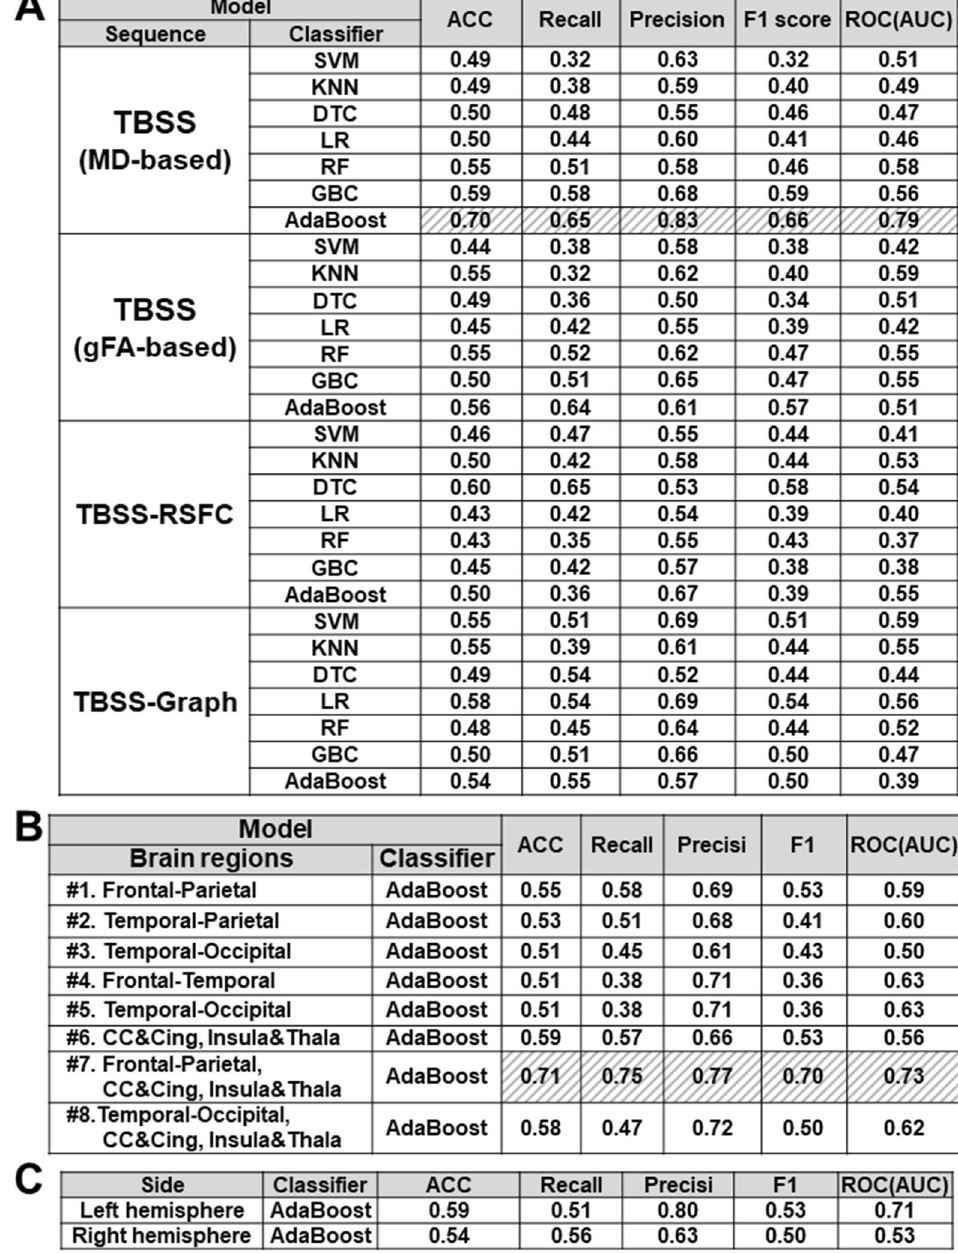
Figure 4. EMCI/LMCI classification performance in ML models with feature subsets. ( A ) The table indicates the EMCI/LMCI classification performance of ML models (SVM, KNN, DTC, LR, RF, GBC, AdaBoost), using four feature subsets by gFA-based TBSS, MD-based TBSS, TBSS-RSFC, and TBSS-Graph method. The performance was assessed by measuring mean accuracy (ACC), recall, mean precision, F1 score, and AUC (ROC). ( B ) The useful brain regions for EMCI/LMCI classification. With features extracted from each combination of brain regions, the classification performance of AdaBoost was evaluated by measuring mean accuracy (ACC), recall, mean precision, F1 score, and AUC (ROC). The brain regions were subclassified into each combination of #1. Frontal and Parietal lobe, #2. Temporal and Parietal lobe, #3. Temporal and Occipital lobe, #4. Frontal and Temporal lobe, #5. Temporal and Occipital lobe, #6.CC&Cing, Insula& Thalamus regions, #7. Frontal and Parietal lobe, Corpus Callosum (CC) and cingulum (Cing), and Insula and Thalamus regions. ( C ) The useful brain hemisphere for EMCI/LMCI classification. With features extracted from the right or left hemisphere, the classification performance of AdaBoost was evaluated by measuring mean accuracy (ACC), recall, mean precision, F1 score, and AUC (ROC). RSFC resting-state functional connectivity, ROI range of interest, ML Machine learning, SVM support vector machine, KNN k-nearest neighbor algorithm, LR Logistic Regression, DTC decision tree classifier, RF Random Forest, GBC gradient boosting classifier, ACC accuracy, AUC Area under the curve, ROC Receiver operating characteristic, CC Corpus